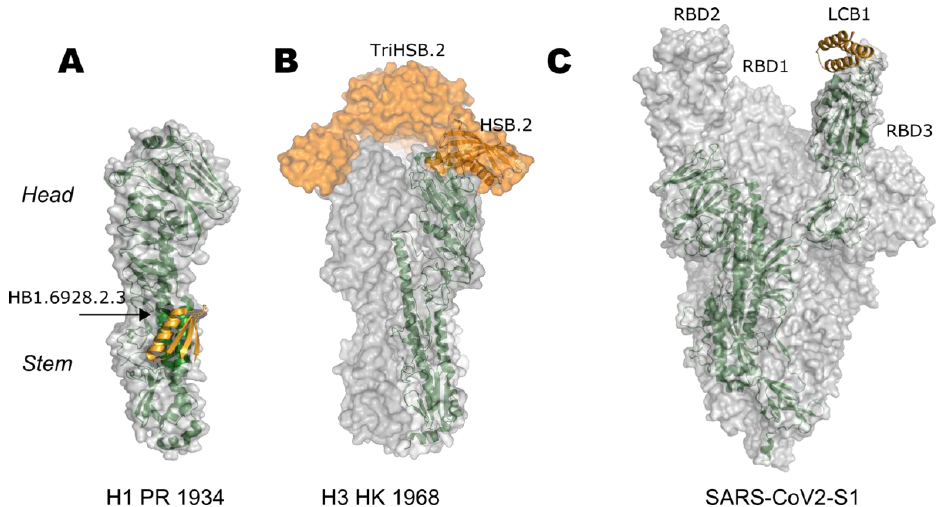
Figure 2. Designed small protein inhibitors targeting fusion proteins. All proteins have been depicted as transparent surfaces with monomeric units highlighted in forest green. Protein inhibitors are colored orange ( A ) HSB1.6928.2.3 targeting the stem region of H1 HA (PDB 5VLI); ( B ) TriHSB.2A targeting the receptor-binding site on the head region of H3 HA 1968 strain (PDB 5KUY and model); ( C ) LCB1 bound to the open conformation of the receptor-binding domain of prefusion stabilized ectodomain trimer of SARS-CoV-2 spike protein (PDB 7JZL).